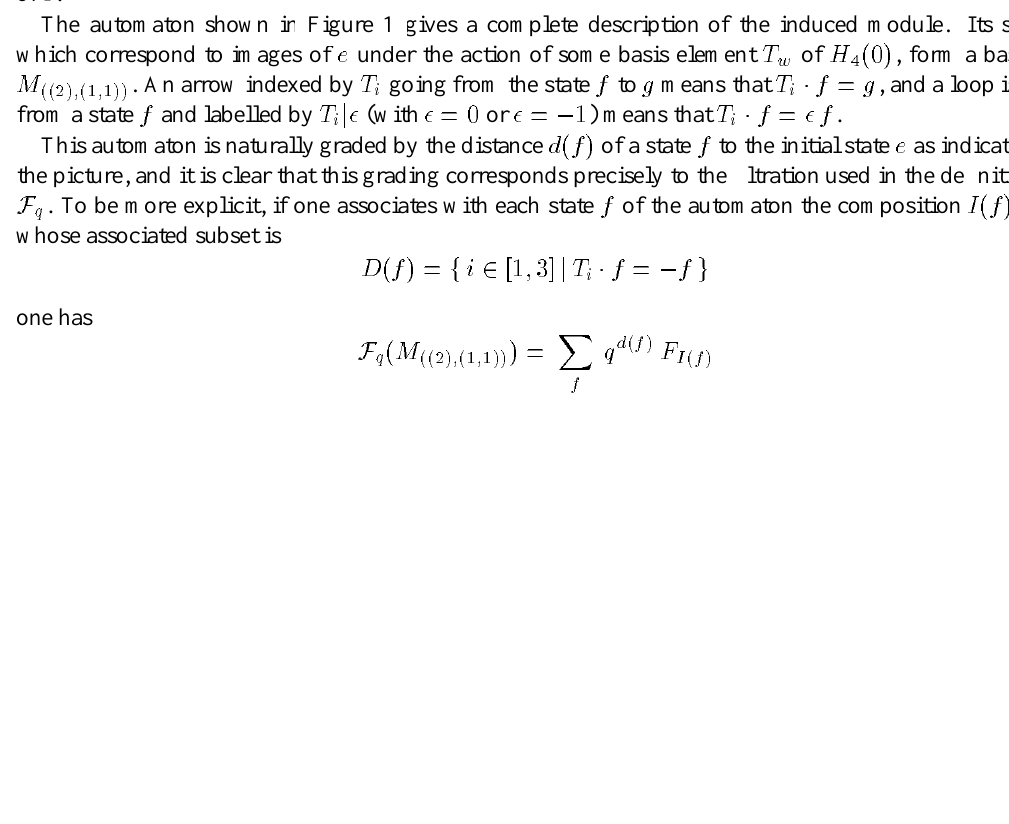
-module H4(0) M((2);(1;1))